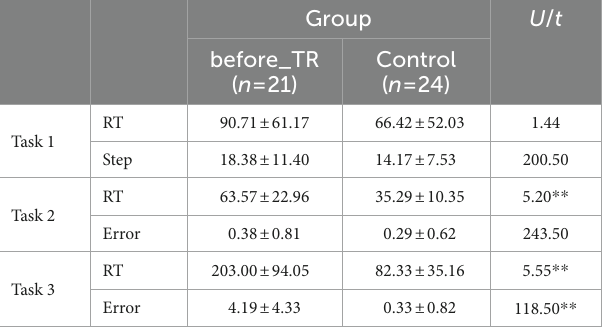
TABLE 2 Behavioral indicators in the cool executive tasks for the before_ TR group and the control group.